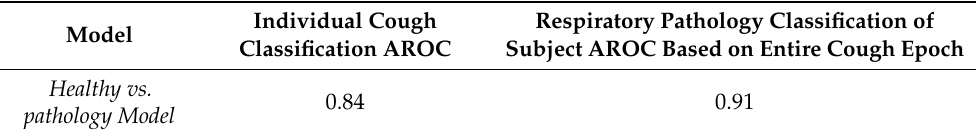
Table 4. AROC of Healthy vs. pathology model.